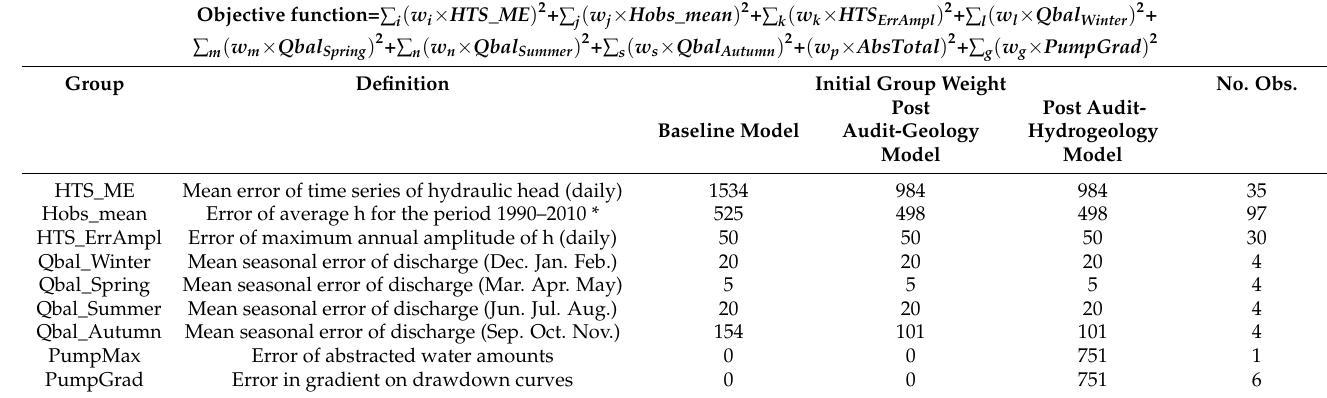
Table 1. The objective function and nine embedded groups used for the three